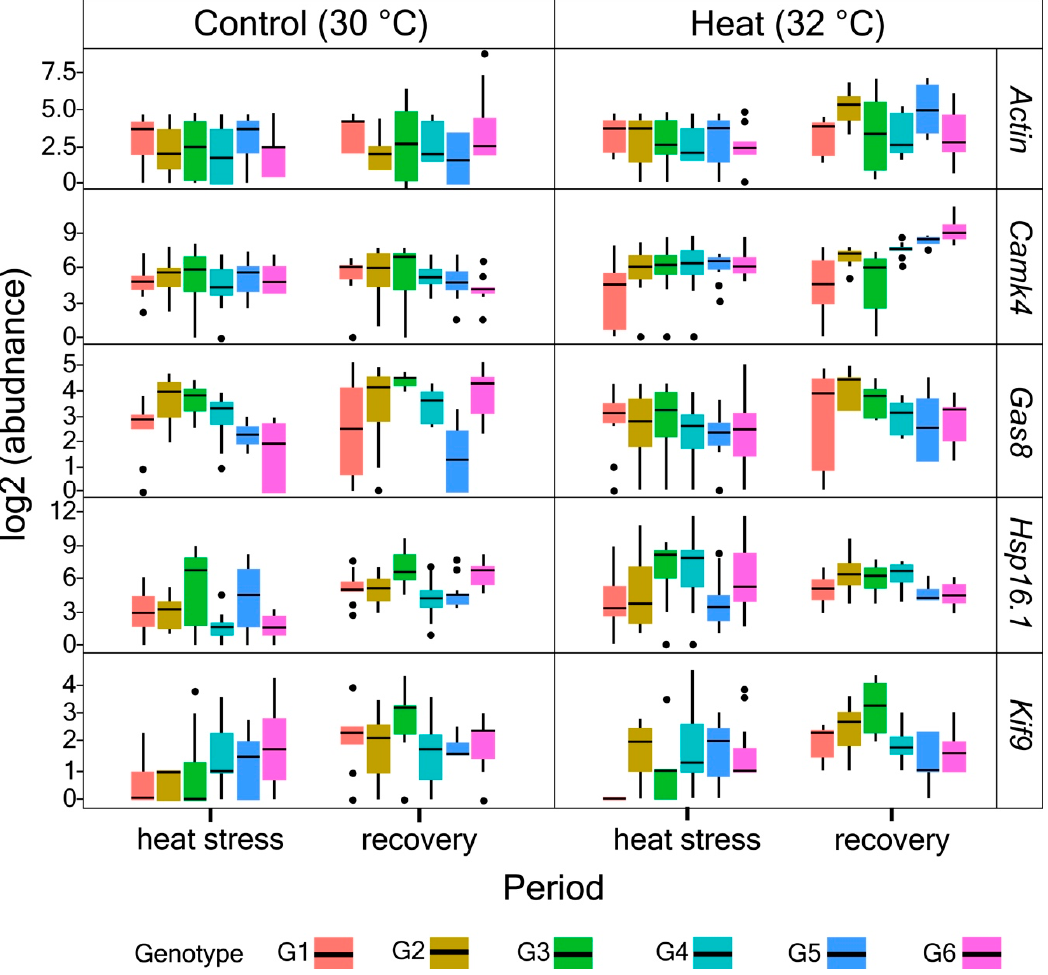
Figure 4. Changes in expression levels of all genes (log2-transformed) for all colonies examined across experimental conditions.